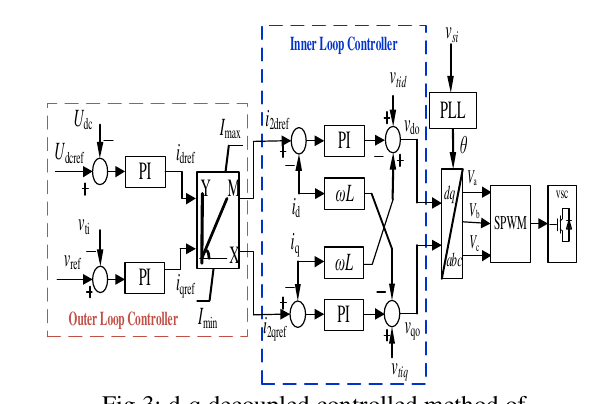
Fig.3: d-q decoupled controlled method of STATCOM [9]